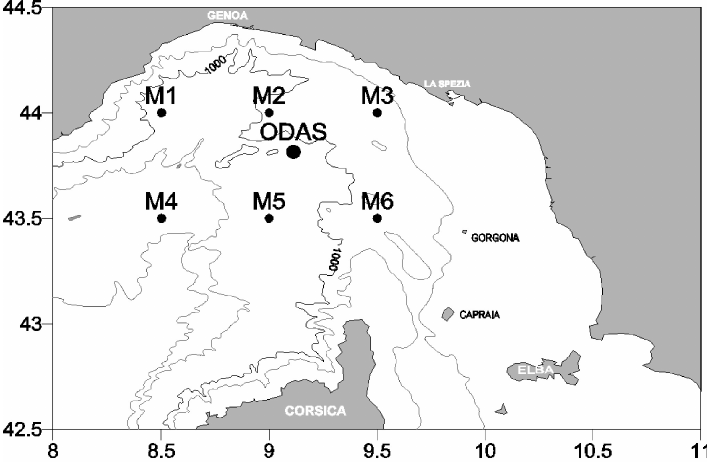
Fig. 2. Map of the Ligurian Sea, in- cluded between the Italian Riviera and Corsica Island, showing the location of the ODAS Italia 1 buoy and the ECMWF grid points used in the anal-